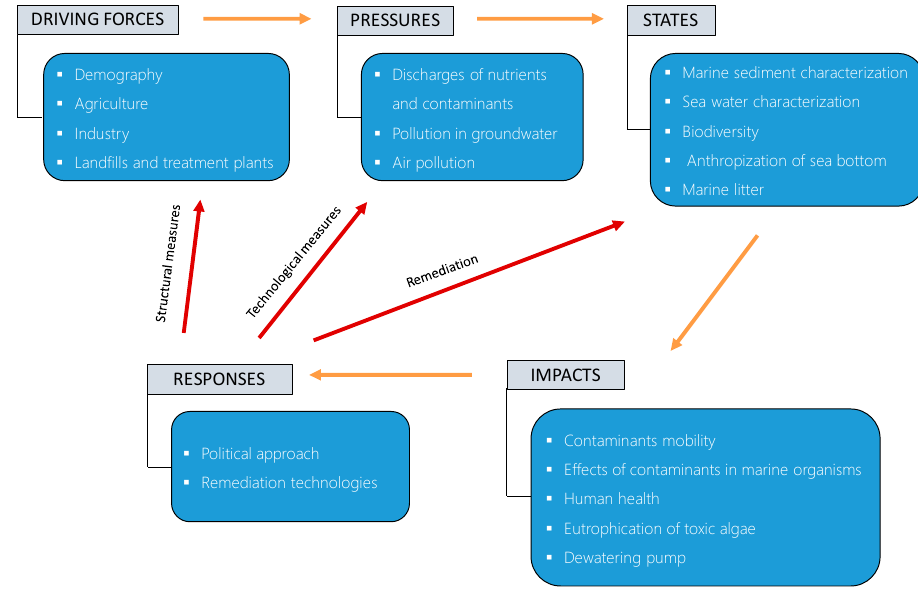
Figure 1. DPSIR framework of the study.